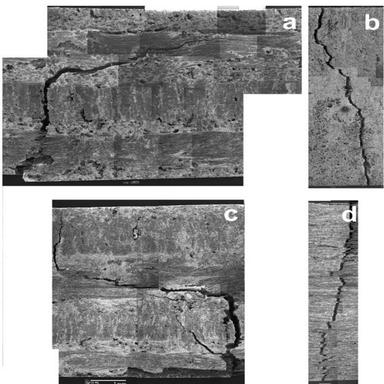
Low magnification SEM images of Cf-HfB2 powder composites after flexural testing. (a) Strongest sample; cross-section fracture view, (b) strongest sample; surface fracture view, (c) weakest sample; cross-section fracture view, (d) weakest sample; surface fracture view.